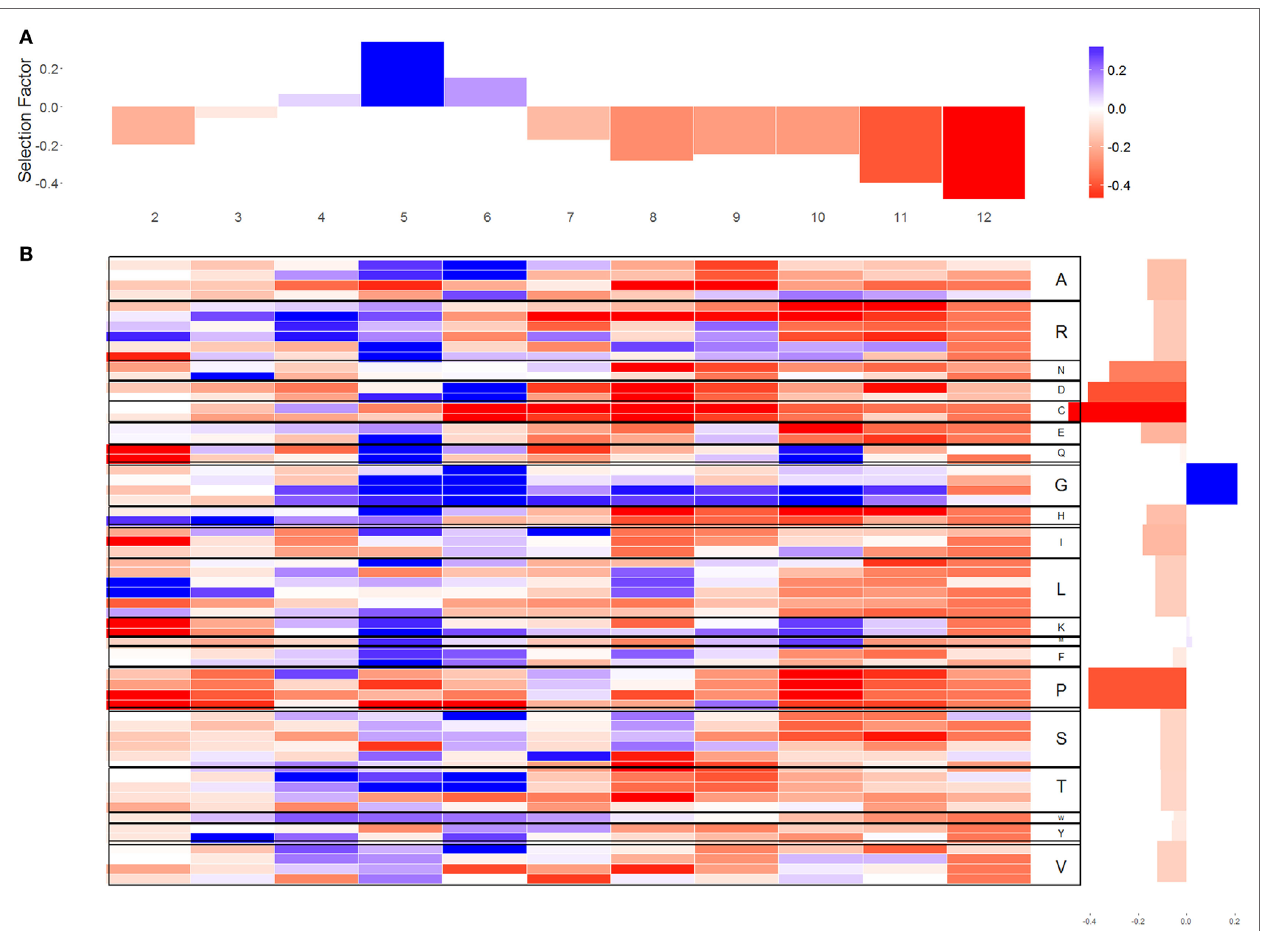
FigUre 2 | Selection factors for sequences. (a) The average of the q -values for each location in CDR3 in log scale [positive selection represented by positive values log( q ) > 0 and negative selection represented by negative values log( q ) < 0]. (B) The x -axis represents the different location in CDR3; the y -axis represents the different codons. In the right side of the figure, each codon is translated to its amino acid. The blue cells represent log( q ) values larger than 0 for codon in a certain position. The red cells represent log( q ) values lower than 0. The white cells indicate that there was no